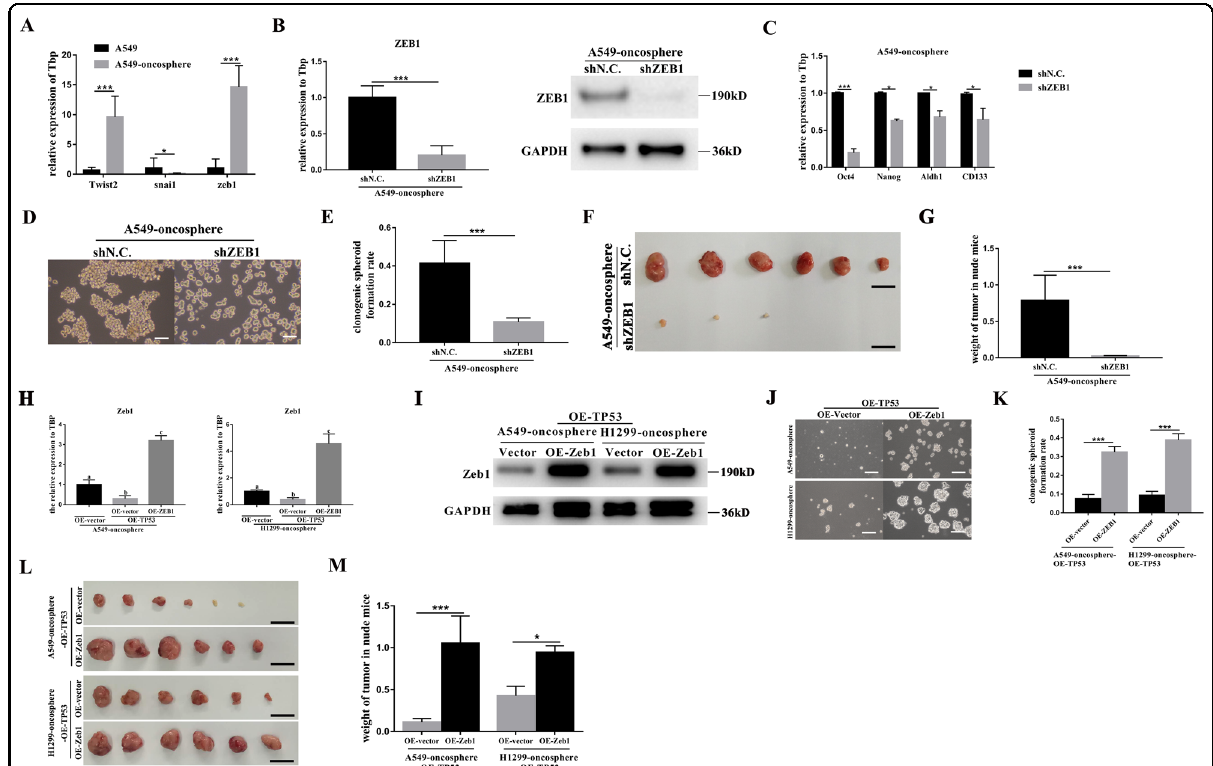
Fig. 5 Zeb1 is the downstream effector of p53 in regulating the stemness of human lung CSCs. A Analysis of mRNA expression of Twist2, Snail1, and Zeb1 in A549 and A549-oncosphere; Tbp was used as a reference control, * p < 0.05, *** p < 0.01. B Analysis of mRNA expression and protein level of Zeb1 in A549-oncosphere after TP53 silencing (A549-oncosphere-shZEb1); Tbp and GAPDH were used as a references controls, *** p < 0.01. C Analysis of mRNA expression of Oct4, Nanog, Aldh1, and CD133 upon Zeb1 silencing (A549-oncosphere-shZEB1); Tbp was used as a reference control, * p < 0.05, *** p < 0.01. Colony formation assay ( D bar = 120 µm) and single-cell cloning assay ( E *** p < 0.01.) using A549-oncosphere cells in which Zeb1 was silenced (A549-oncosphere-shZEB1). F , G Analysis of the tumors obtained from nude mice receiving A549-oncosphere-shN.C. and A549-oncosphere-shZEB1 cells, *** p < 0.01. Bar = 1 cm. H Analysis of mRNA expression of Zeb1 in A549-oncosphere-OE-TP53 and H1299- oncosphere-OE-TP53 after overexpression of Zeb1, the control groups were A549-oncosphere-OE-vector and H1299-oncosphere-OE-vector, respectively. Tbp was used as a reference control, different superscripts represent signi fi cant differences, p < 0.05. I Analysis of protein level of Zeb1 in A549-oncosphere-OE-TP53 and H1299-oncosphere-OE-TP53 after overexpression of Zeb1, the control groups were A549-oncosphere-OE-vector and H1299-oncosphere-OE-vector, respectively. GAPDH was used as a reference control. Colony formation assay ( J bar = 120 µm) and single-cell cloning assay ( K *** p < 0.01.) using A549-oncosphere-OE-TP53 and H1299-oncosphere-OE-TP53 overexpressing Zeb1 (A549-oncosphere-OE-TP53-OE-ZEB1 and H1299-oncosphere-OE-TP53-OE-ZEB1). L , M Subcutaneous tumors exercised ( L , images; M : tumor weight, * p < 0.05, *** p < 0.01) from nude mice receiving A549-oncosphere-OE-TP53 and H1299-oncosphere-OE-TP53 overexpressing Zeb1 (A549-oncosphere-OE-TP53-OE-ZEB1 and H1299- oncosphere-OE-TP53-OE-ZEB1). Bar = 1